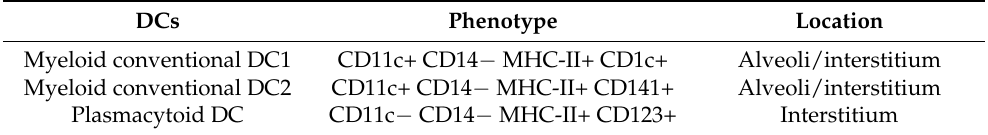
Table 2. Phenotypes of alveolar DCs.